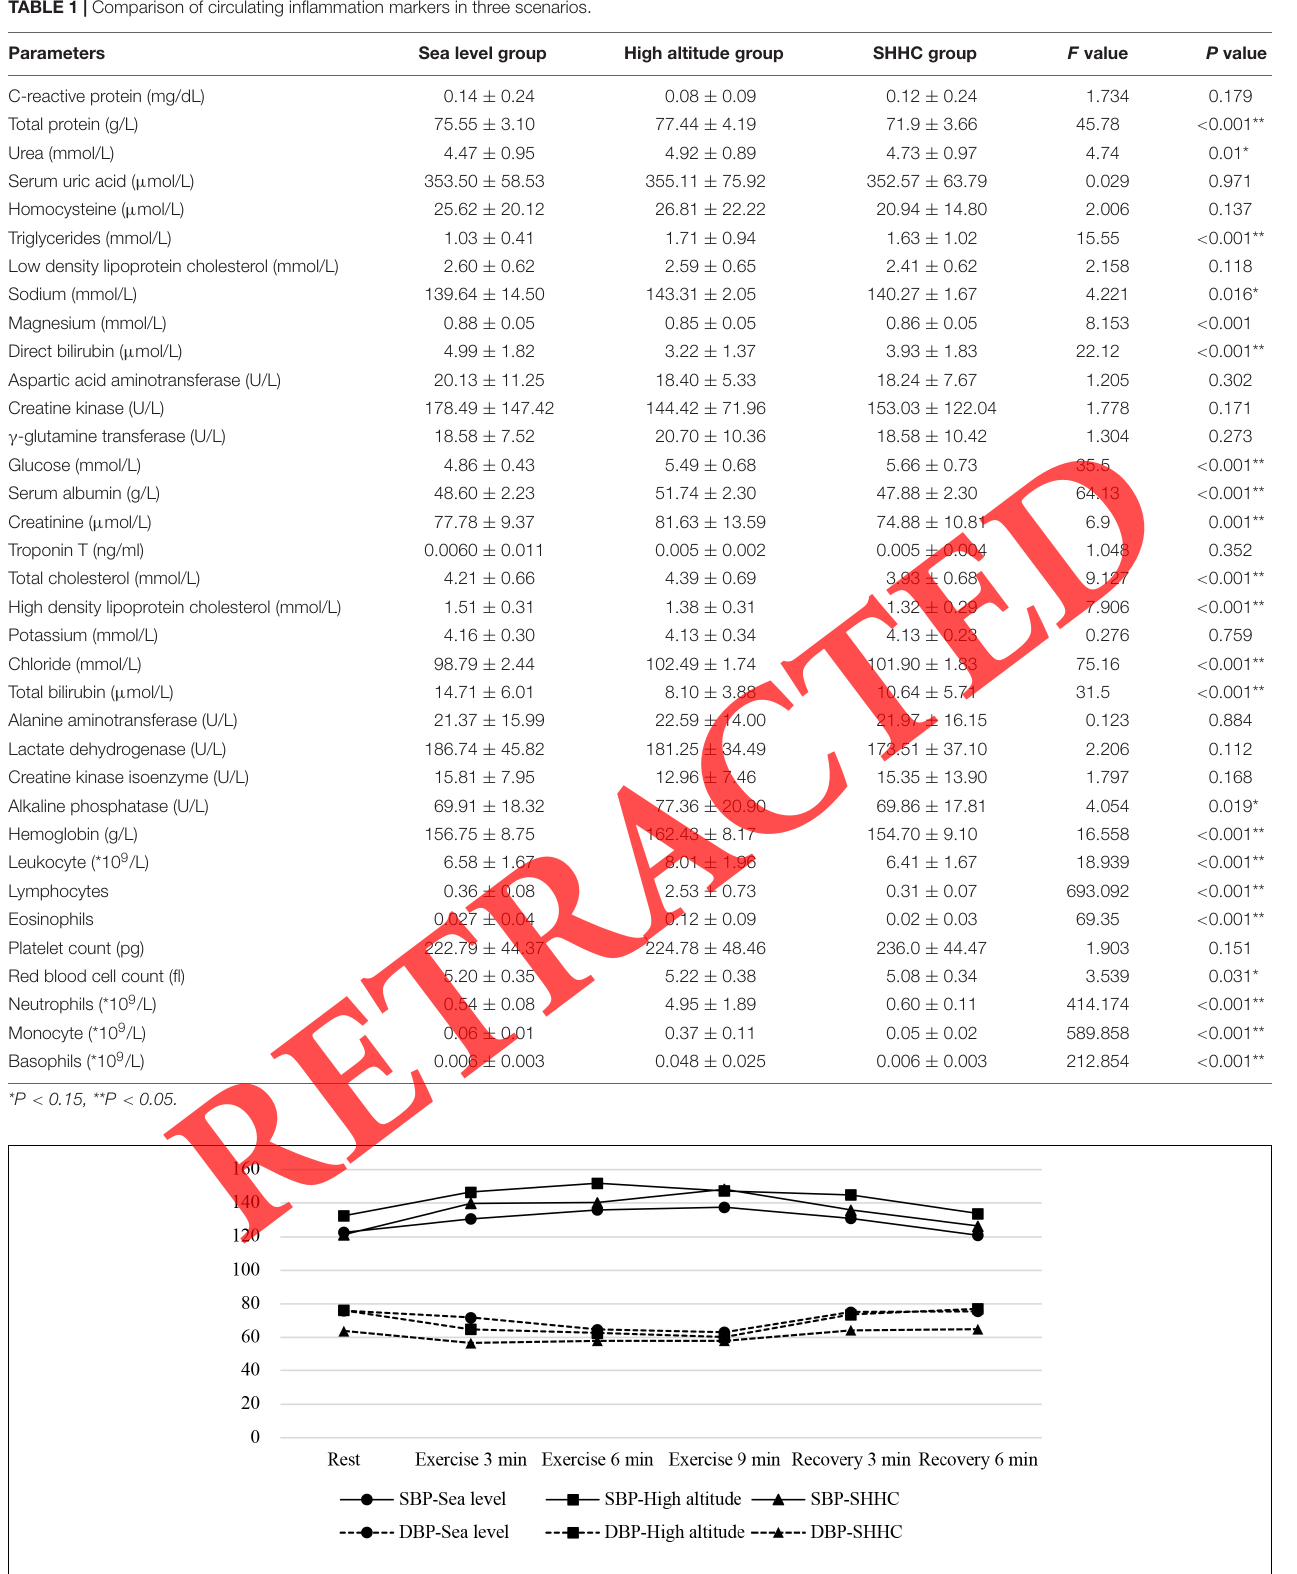
FIGURE 1 | Blood pressure changes during